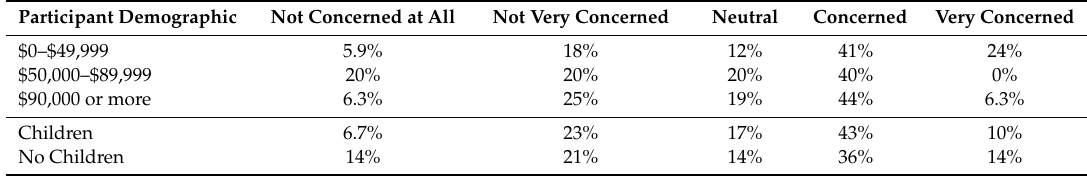
Table A9. Participants’ concern regarding potential health e ff ects of heavy metal contaminants in soil.